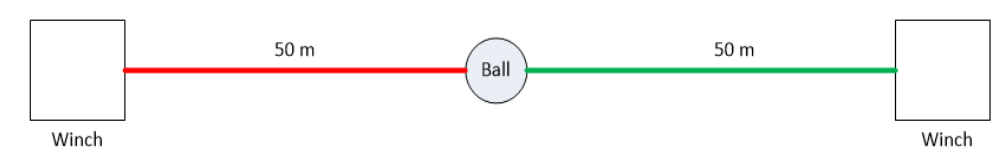
Figure 28. The first